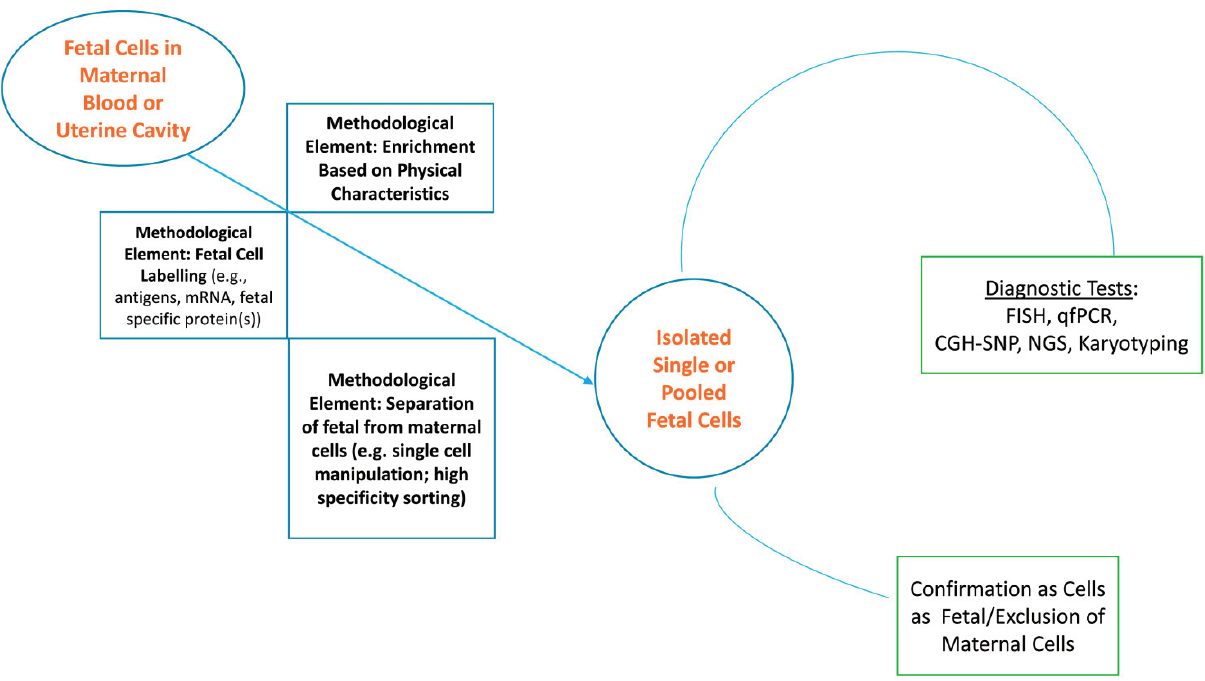
Figure 1. Schema for the capture and analysis of fetal cells for prenatal